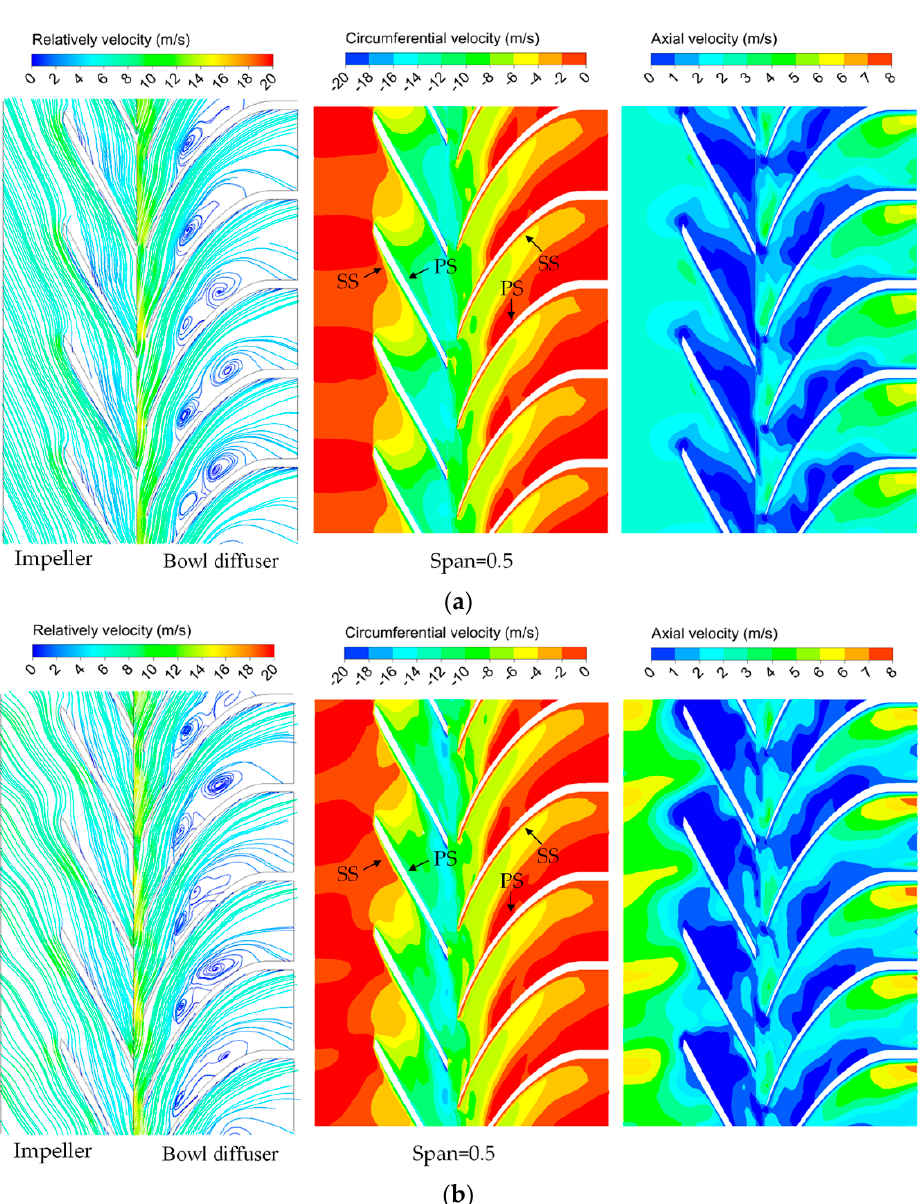
Figure 8. Relatively velocity, circumferential velocity, and axial velocity of continuous phase on the spanwise surface at 1.2 s: ( a ) the first stage; ( b ) the second stage.